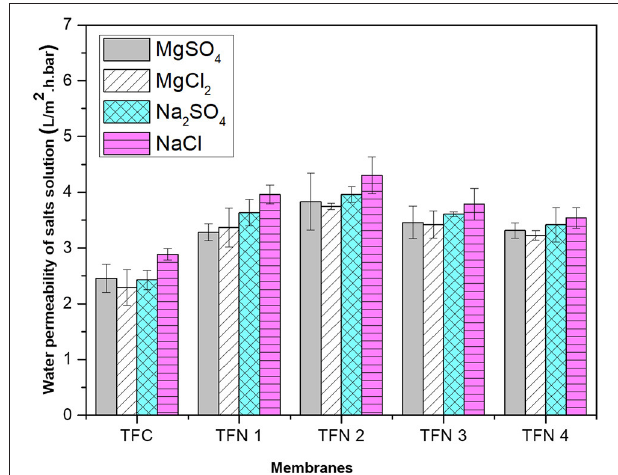
FIGURE 8 | Water permeability of salts solution of different aqueous salt solutions (MgSO 4 , MgCl 2 , Na 2 SO 4, and NaCl).